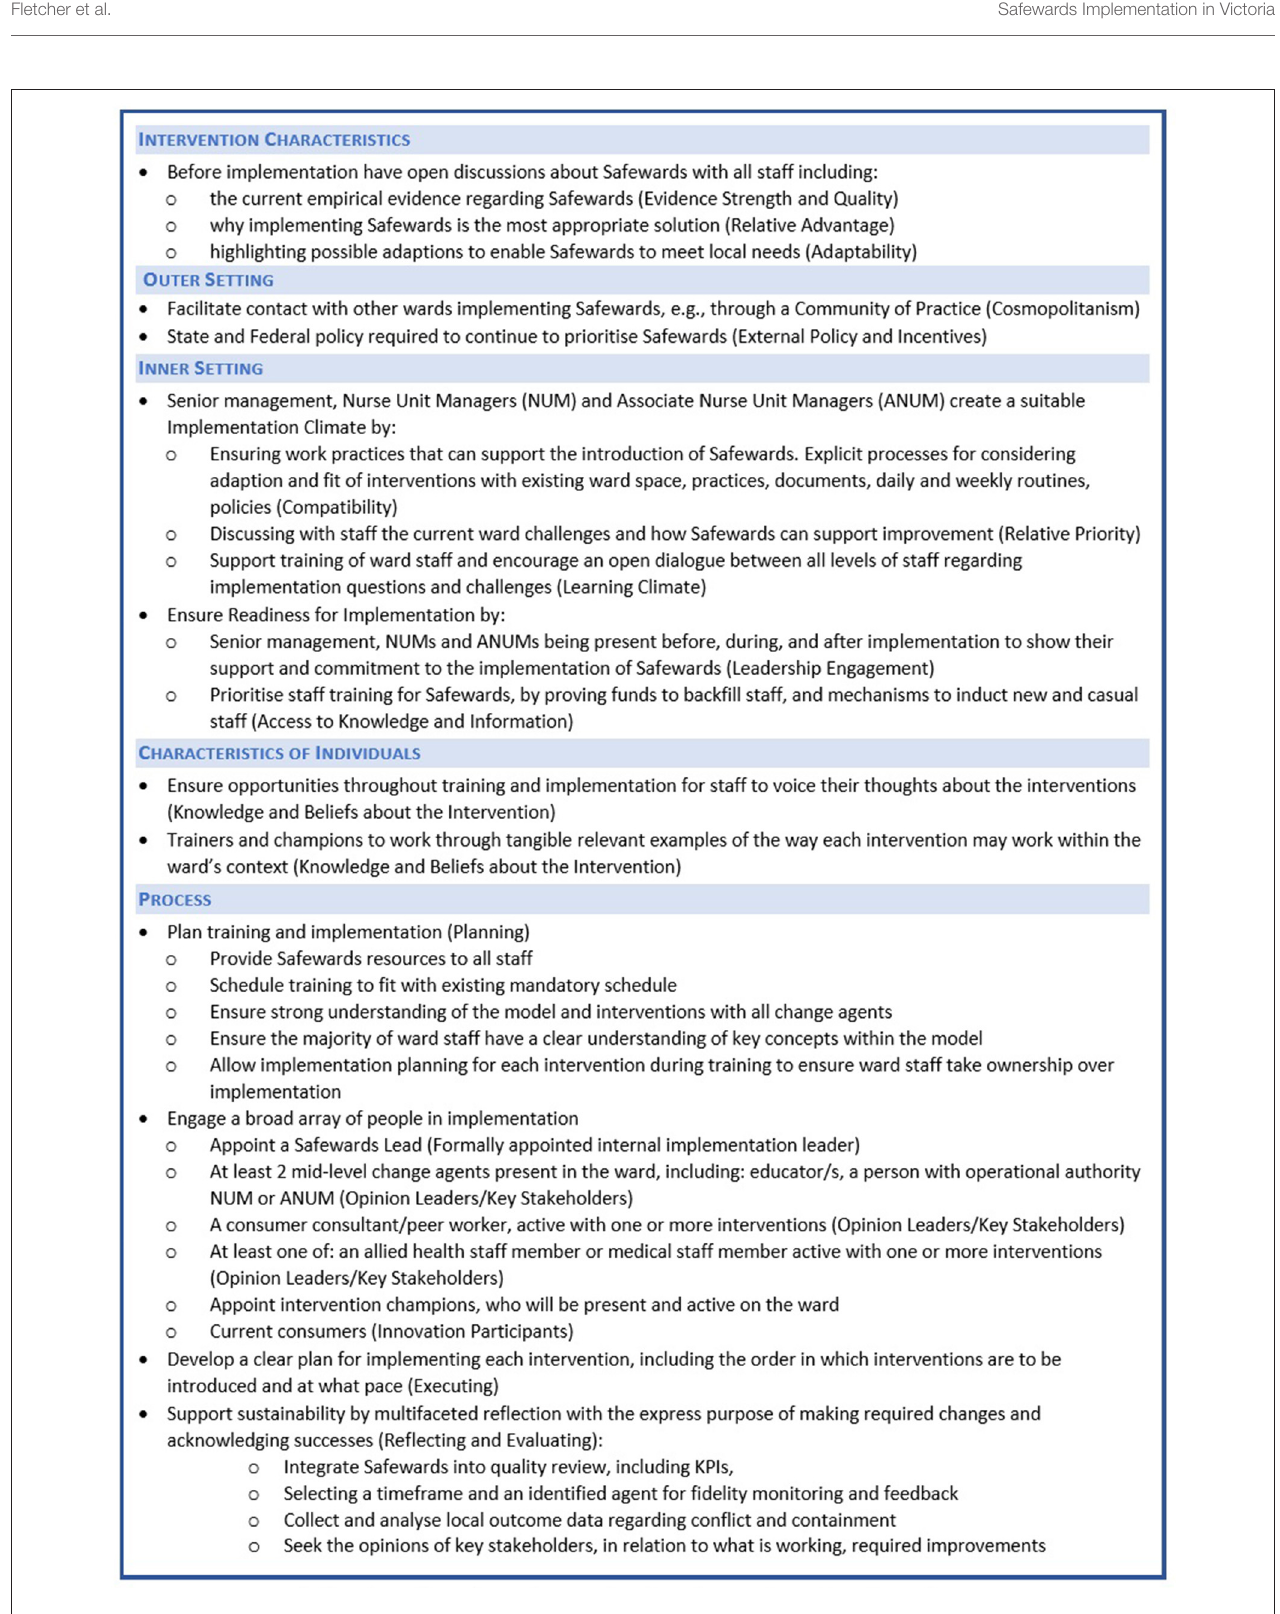
FIGURE 2 | Recommendations for Safewards Implementation based around CFIR domains and constructs.